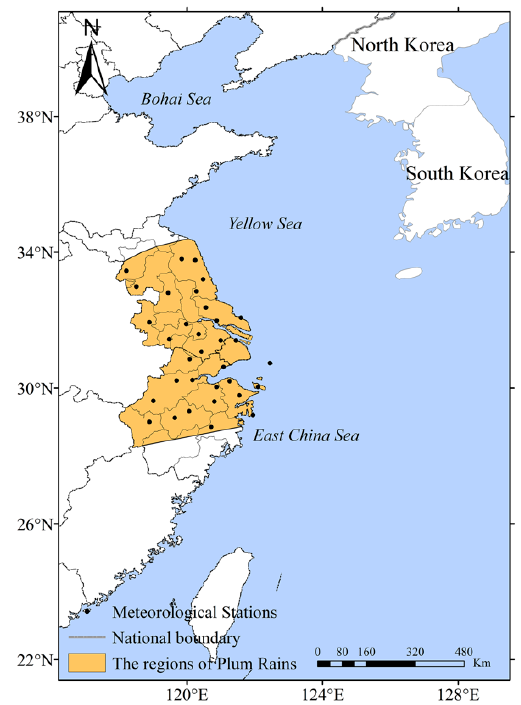
Figure 1. The spatial distribution of 33 meteorological stations and the study area.